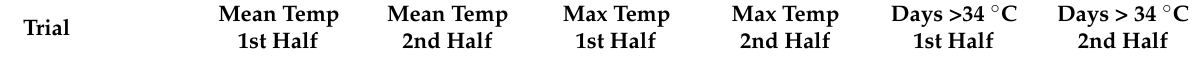
Table 16. Average mean daily temperatures ( ◦ C), average maximum daily temperatures ( ◦ C) and number of days greater than 34 ◦ C during the first (flowering) and second (seed development) halves of the period between commencement of flowering and harvest for variety BEW (Multiple correlation coefficient R and probability p -value are presented for regressions with seed yield of BEW from Tables